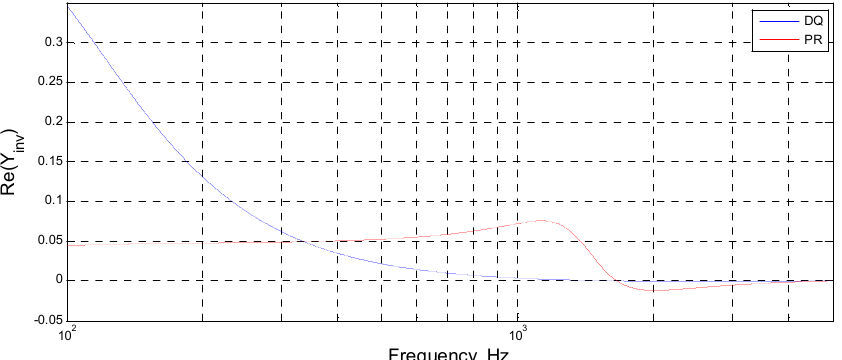
Figure 11. The real part of the inverter output admittance; blue for the dq-based control method and red for the PR-based control method.